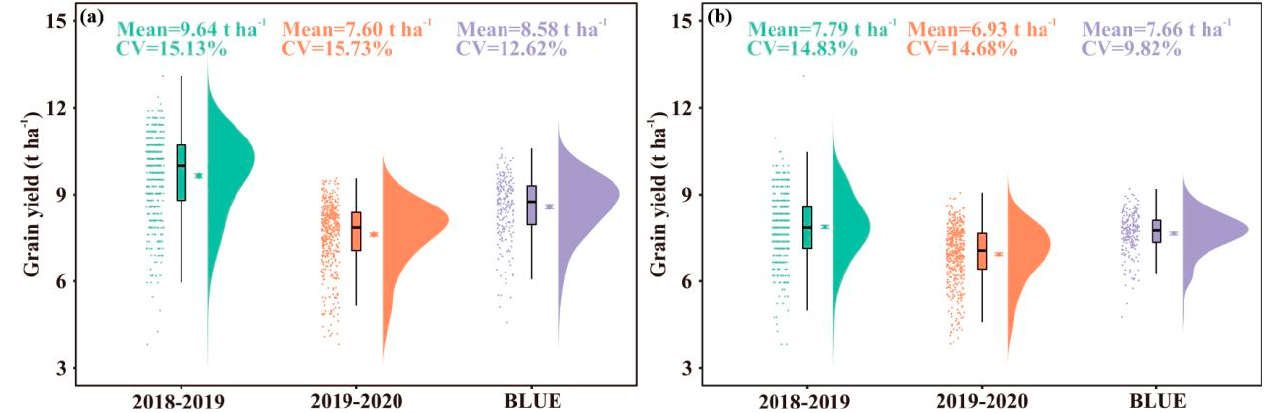
Figure 2. Grain yield distribution for two growing seasons 2018–2019 and 2019–2020 under ( a ) full irrigation treatment and ( b ) limited irrigation treatments. CV is coefficient of variation.